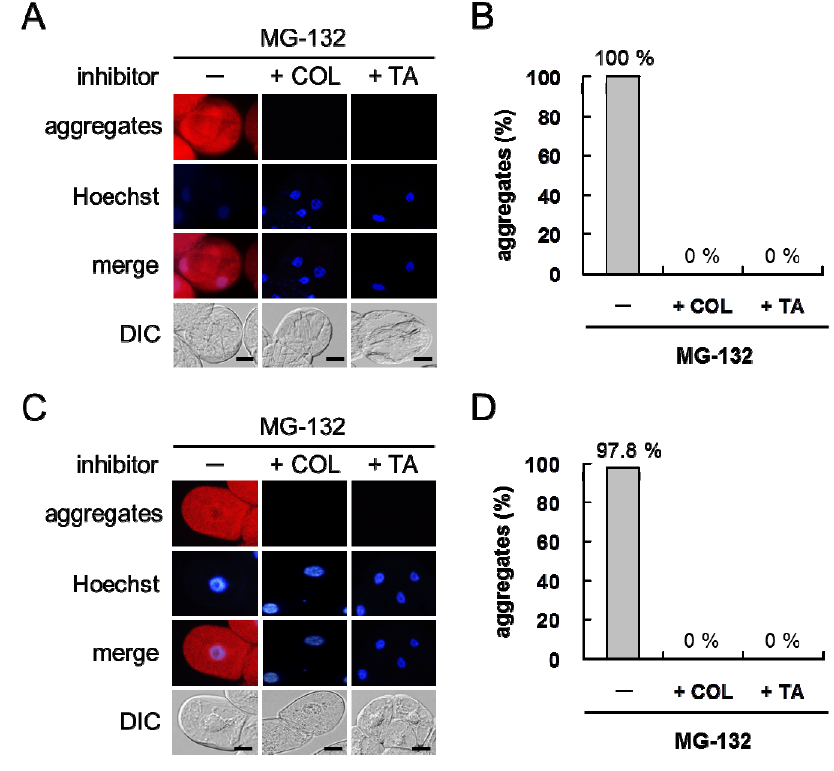
Figure 2. Effect of trichostatin A or colchicine treatment on misfolded protein aggregation in plant cells. ( A and C ) Microscopy observation; ( B and D ) Incidence of misfolded protein aggregation. Cotreatment with trichostatin A (TA) or colchicine (COL) and MG-132 completely suppressed misfolded protein aggregation in grape ( A and B ) and tobacco ( C and D ) cultured cells. The red color and the blue color indicate the fluorescence of detected aggregates and stained nuclei, respectively. Merge, a merged image. DIC, an image observed under a DIC microscope. Scale bars, 20 μ